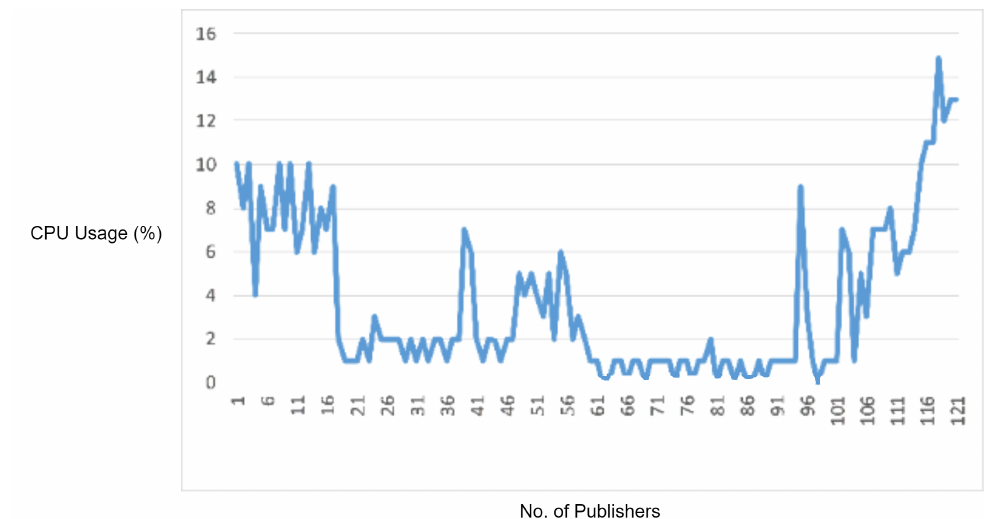
Figure 16. CPU usage captured while performing MQTT DDoS attack when IDS rules are disabled.